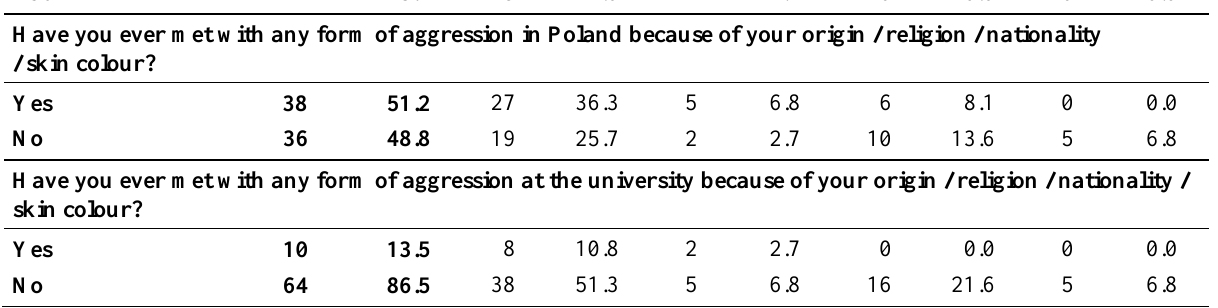
Table 5. International students’ individual assessment of their stay in Poland (N=74) Total Muslims Total N % N % N